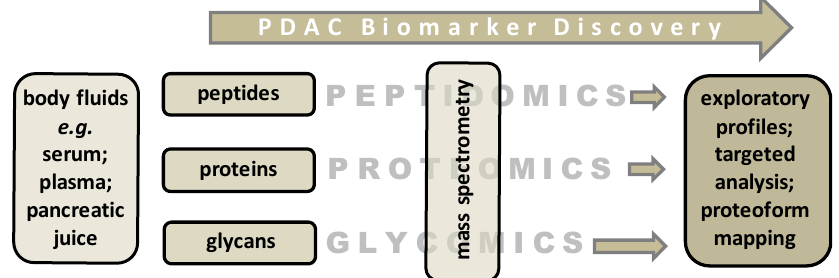
Figure 2. Overview of previous and ongoing PDAC biomarker discovery studies. This review has focused on three types of biomolecules that are obtained from patient body fluids. Potential biomarkers identified from tissue-based samples were out-of-scope. Without detailing the various mass spectrometry technologies, the applied strategies can either have an exploratory or a targeted nature. A third strategy, namely proteoform mapping, is explained in the main text.